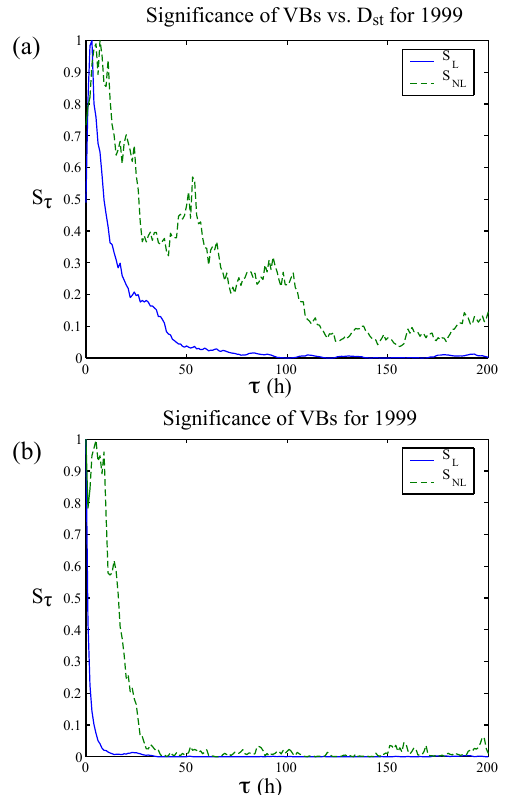
Figure 1. Significance extracted from (a) { VB s (t),D st (t − τ) } and (b) { VB s (t), VB s (t − τ) } for 1999. It should be noted that there is a strong linear response at around 3h time delay. There is a clear nonlinear response with a strong peak around 50h lasting for ap- proximately 1 week. The long-term nonlinear response is absent in the solar wind data, indicating that the long-term nonlinear correla- tions between VB s and D st are the result of internal magnetospheric dynamics.